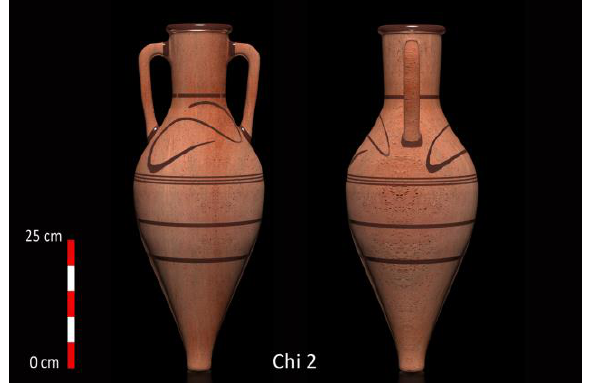
Figure 6. A Chian amphora with a slender and tall body from 575-550